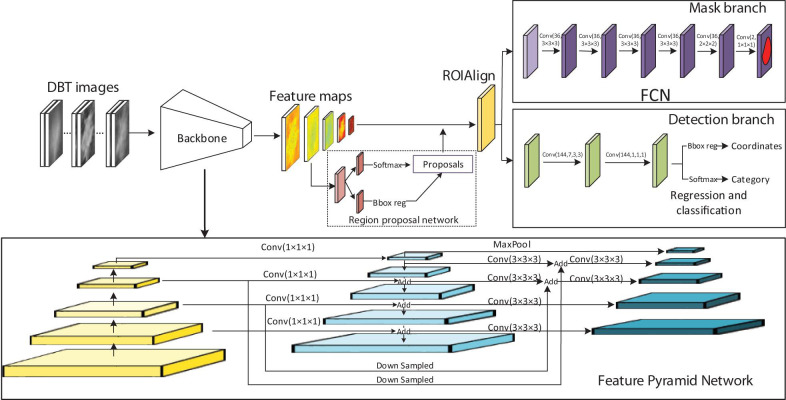
3D Mask RCNN architecture.